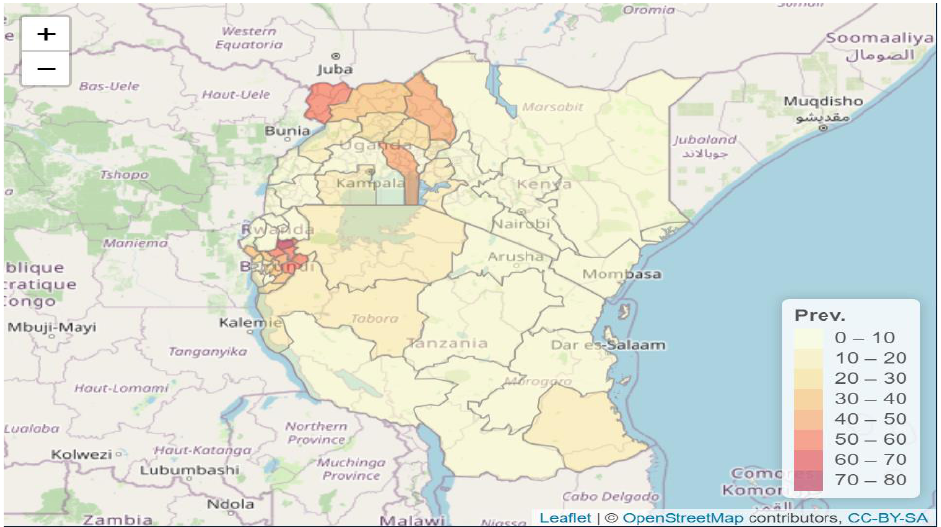
Figure 1. Percentage of children of age 6–59 months that tested positive for malaria in East Africa (Burundi, Kenya, Rwanda, Tanzania, and Uganda at subnational. Source: DHS data). East African community (EAC) member states (Burundi, Kenya, Rwanda,